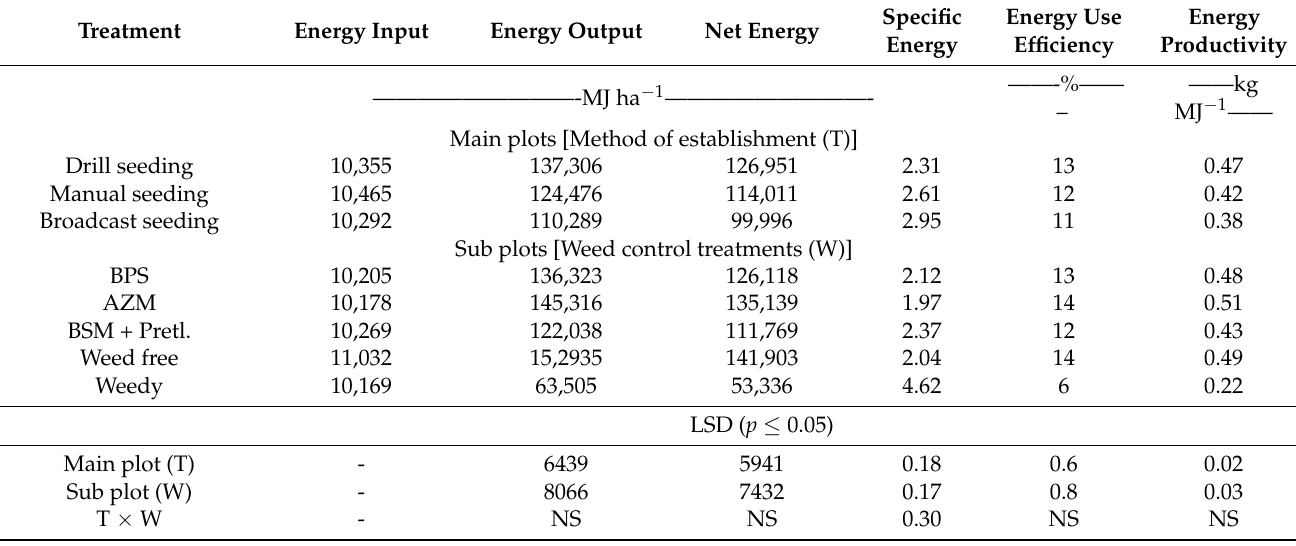
Table 6. Energy balance and productivity as influenced by establishment methods and weed control